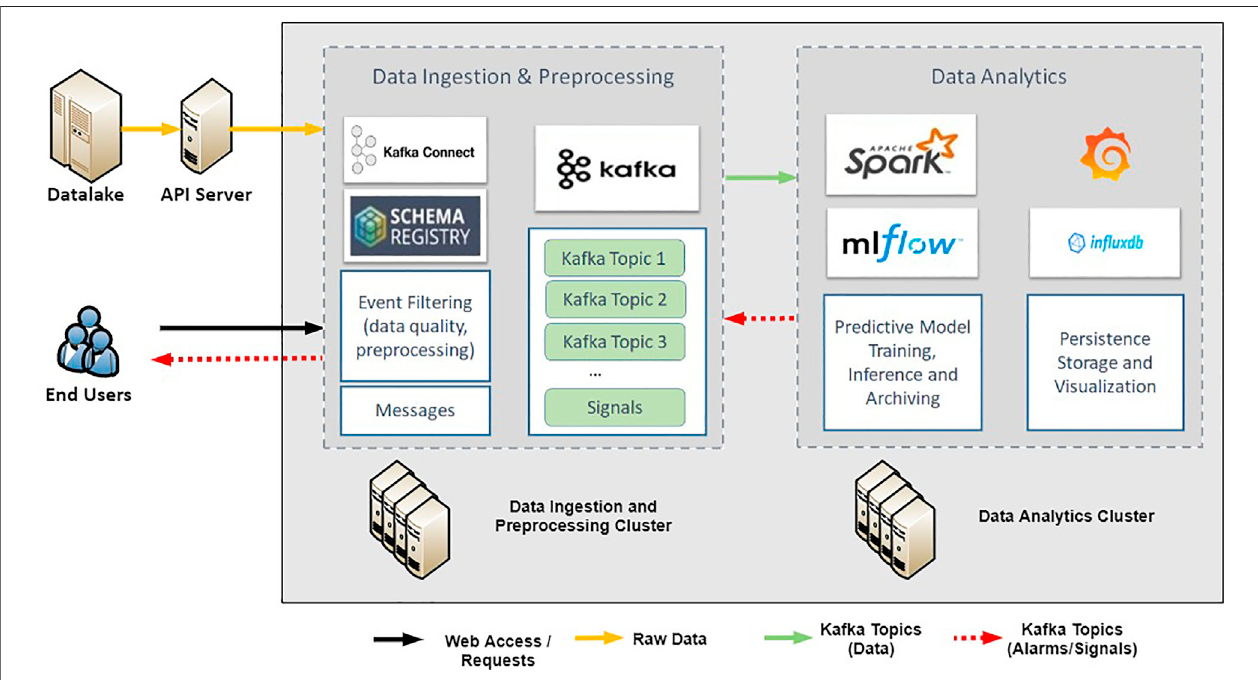
FIGURE 1 | Big Data Management Schema – Infrastructure layout containing main services and information fl